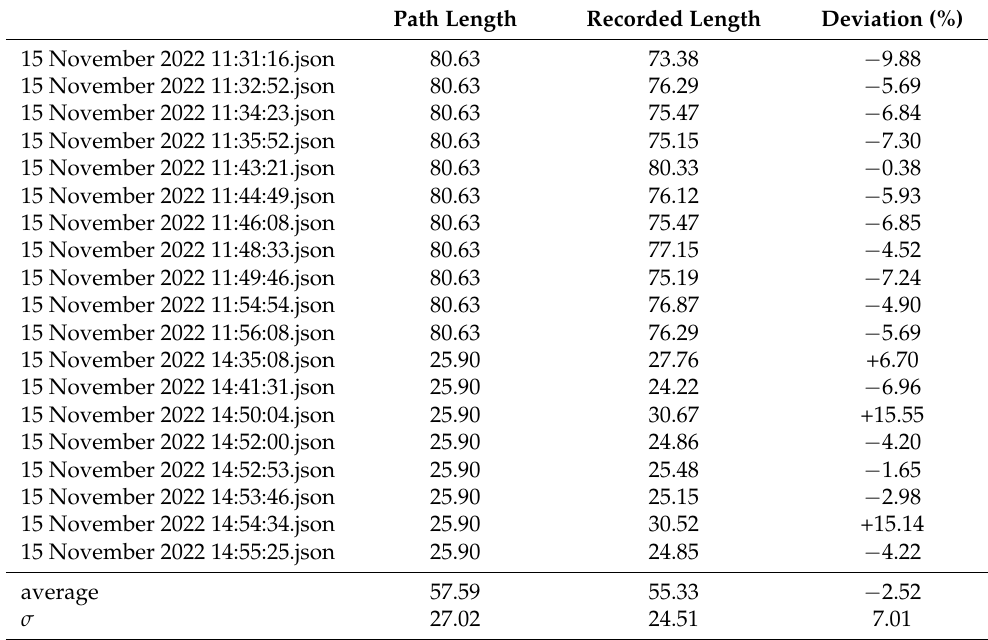
Table 8. Evaluation (Dataset 1 and 2): AR; length-related data.